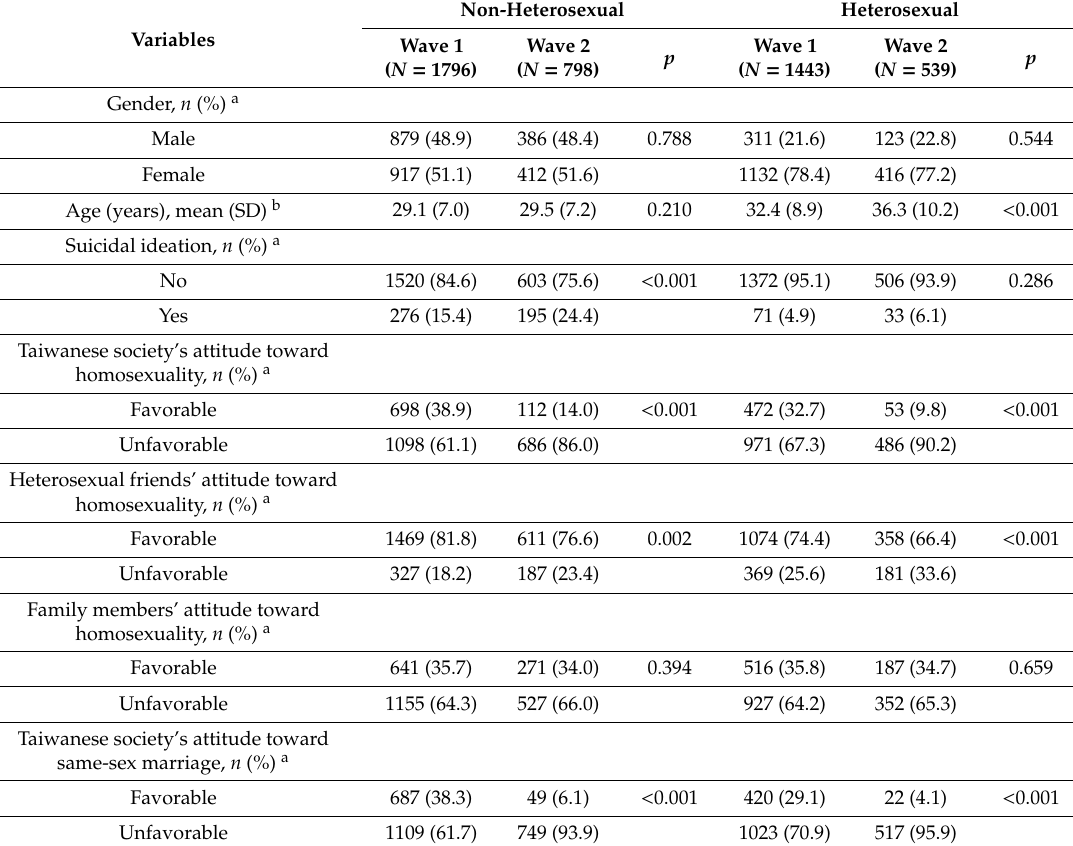
Gender, age, suicidal ideation, and perceived attitudes toward homosexuality and same-sex